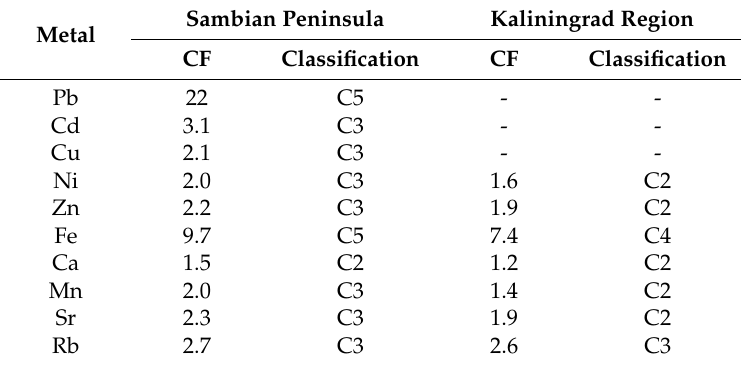
Table 3. Contamination factor in the Kaliningrad region.